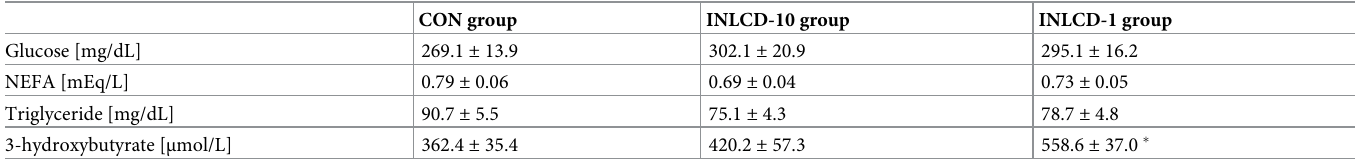
Table 3. Blood parameters.